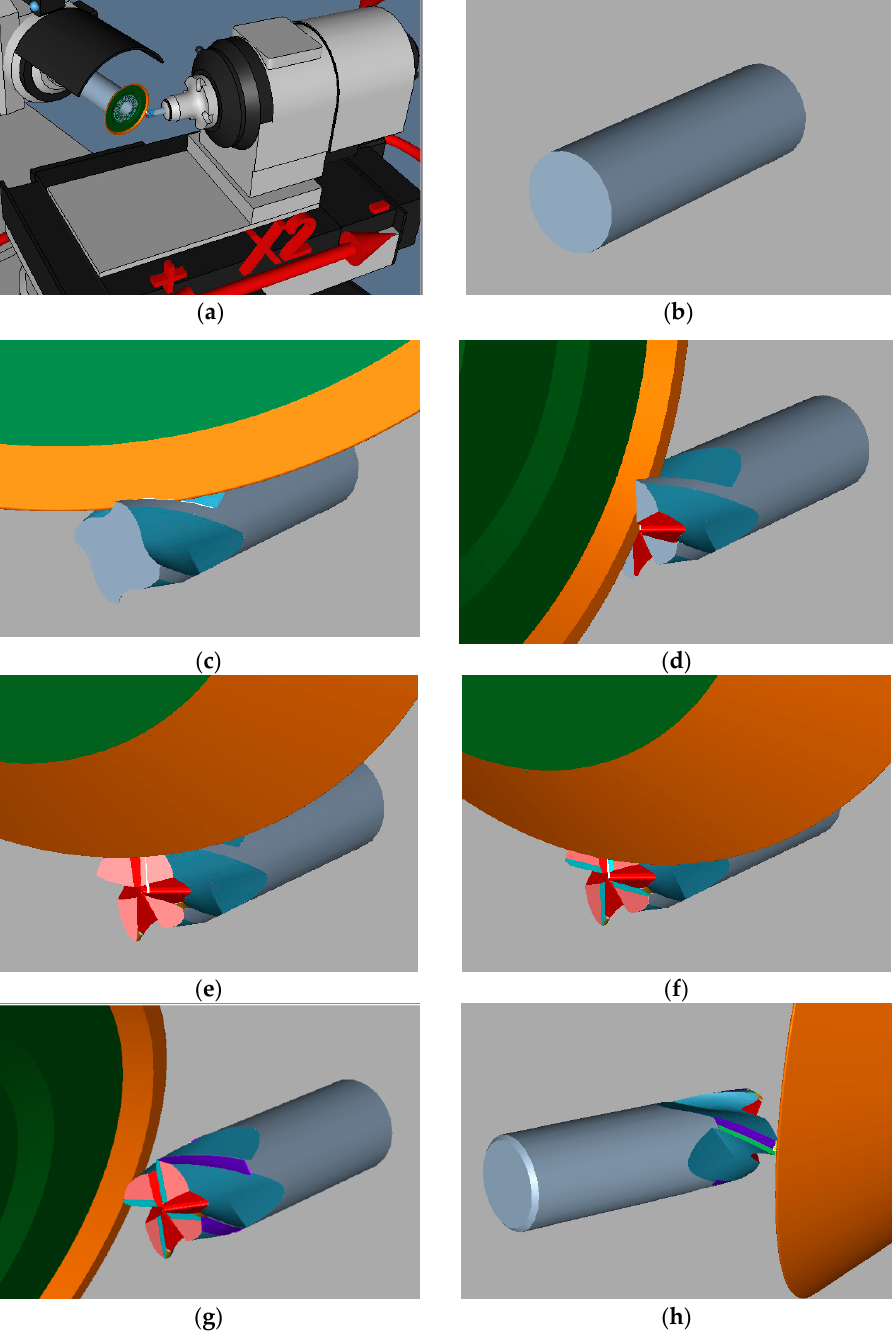
Figure 5. The main stages sequence for diamond sharpening solid ceramic end mill: ( a ) the relative position of the machine spindle and the workpiece when forming a ceramic end mill; ( b ) a ceramic rod; ( c ) grinding the helical chip grooves with a tapered disk; ( d ) grinding the rake face at the end with a cup-bevel wheel; ( e ) grinding the secondary relief surface at the end with a cup-bevel wheel; ( f ) grinding the primary relief surface at the end with a cup-bevel wheel; ( g ) grinding the secondary relief surface at the periphery with the cup-bevel wheel; and ( h ) grinding the secondary relief surface on the transitional radius section with the cup-bevel wheel.